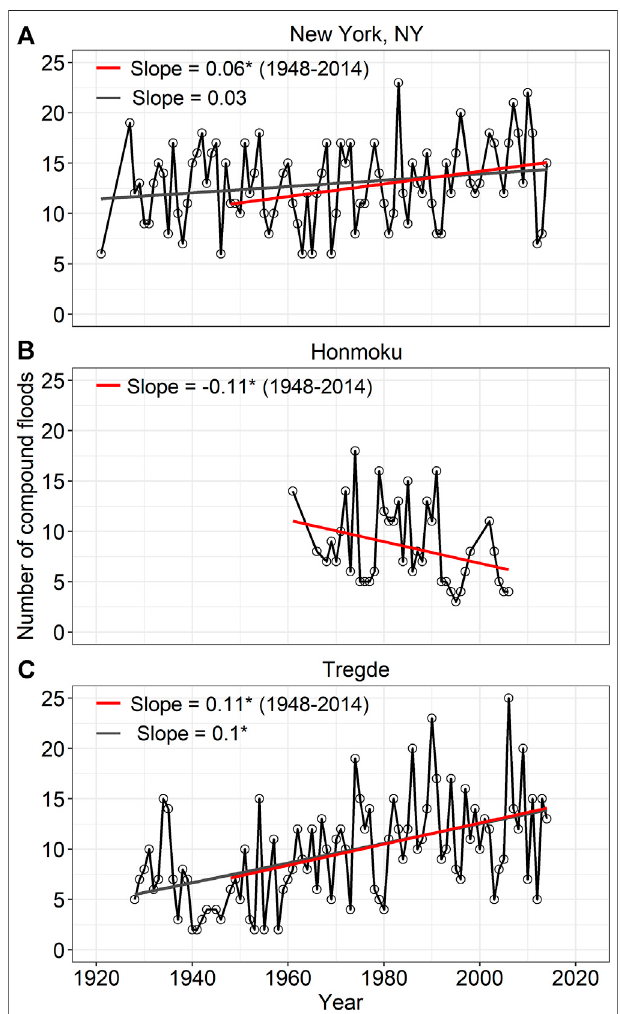
FIGURE 7 | Temporal evolution of the annual number of compound fl ooddaysintidegauge (A) NewYork,NY, (B) Honmoku,and (C) Tregde.The blackstraightlinein (A) and (C) indicatesthetrendofthecompletetimeseries. The red straight line indicates the trend of the time series during 1948 – 2014.TheSen ’ sslopeswereestimated.Signi fi canttrendsareidenti fi ed by an asterisk ( α (cid:1)